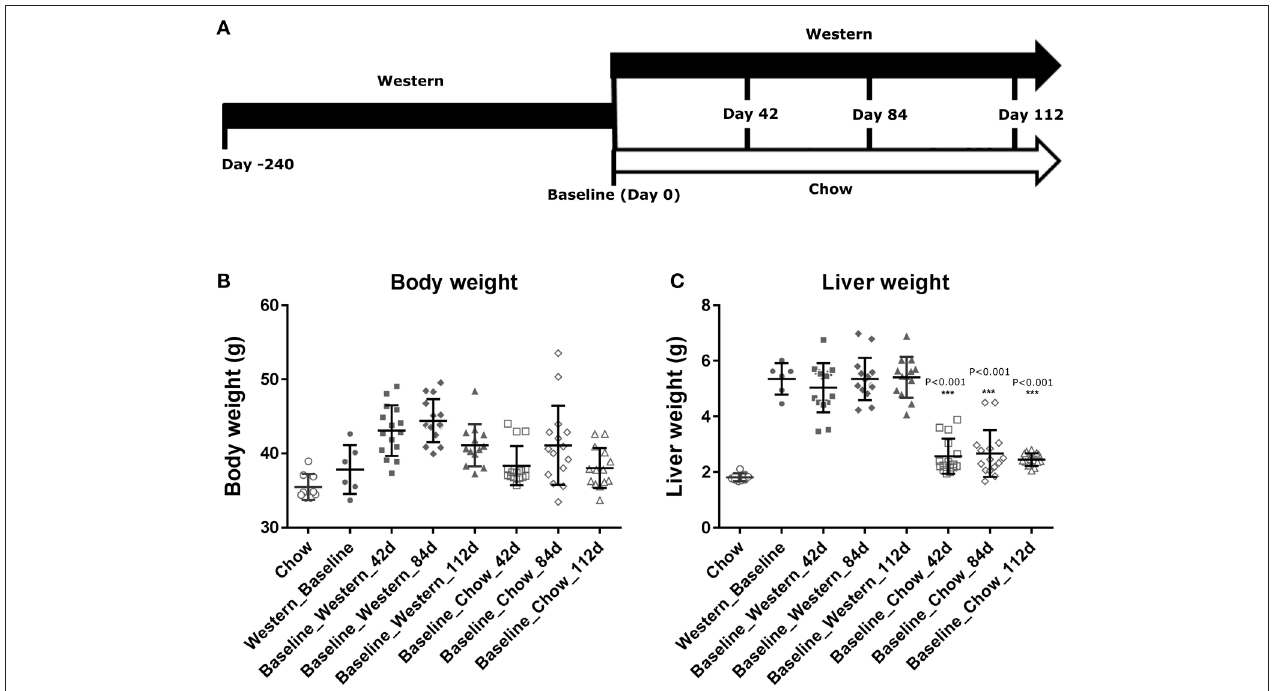
FIGURE 4 | Changes in body and liver weight of the NASH mice after the Western diet was replaced by chow. Male C57BL/6J mice were fed Western diet for 240 days. The Western diet was then replaced by rodent chow as described in (A) . Their body weight (B) was recorded. Their liver weight (C) was measured immediately after euthanasia. The statistical analysis (One way ANOVA) was performed and statistical significance was indicated in the figure ( P < 0.01, *** P < 0.001).